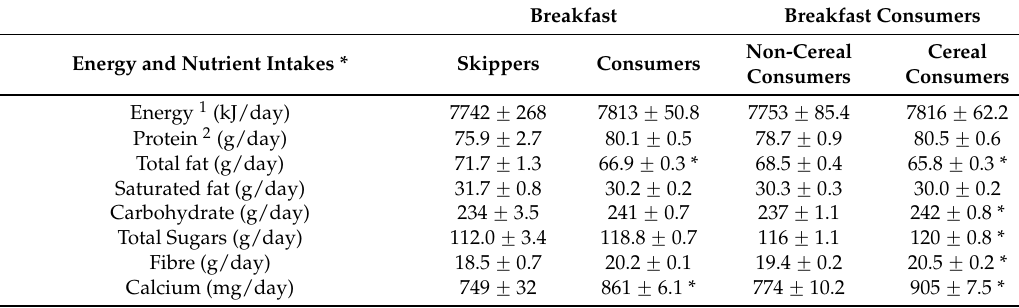
Table 3. Total daily energy and nutrient intake by breakfast